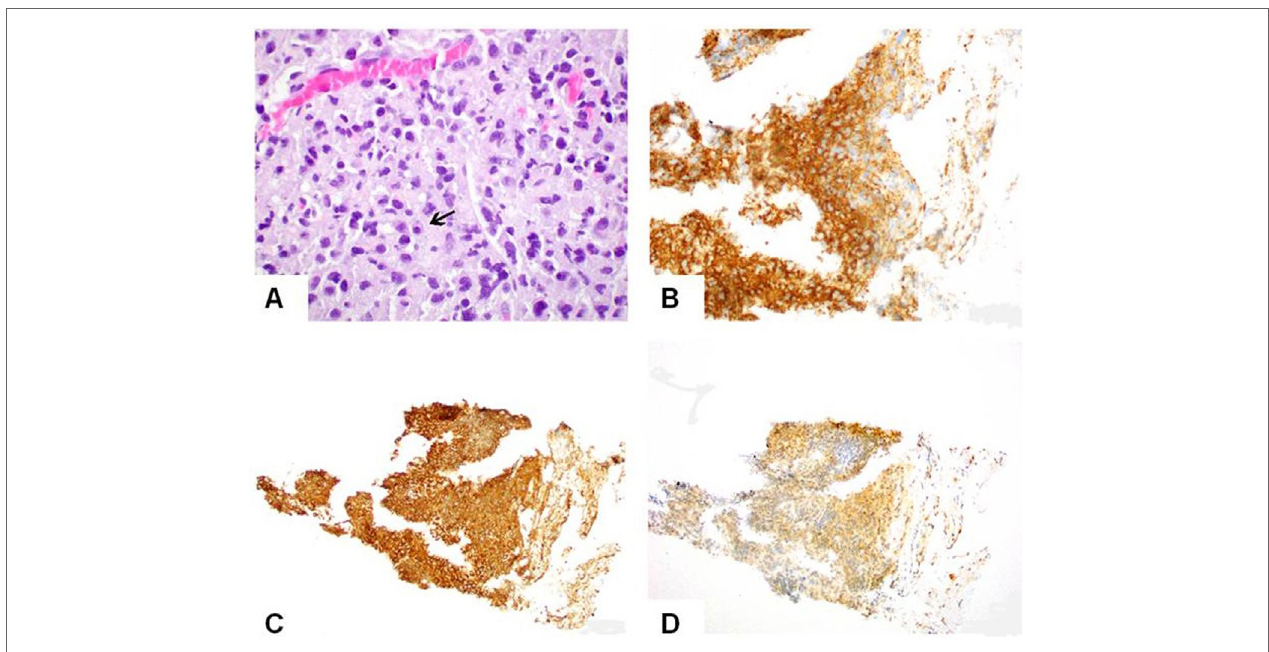
FIGURe 4 | Microscopic pictures of the plasmacytoma. (a) The tumor is entirely composed of plasma cells, some showing the typical perinuclear clearing associated with Golgi apparatus (arrow), H&E, 600 × . (B) Immunostain for CD138 shows positive (golden brown) staining in the tumor (200 × ). (C) Immunostains for lambda and (D) kappa light chains show a significant difference in staining intensity between kappa and lambda chains in favor of lambda chains (200 × ) demonstrating that the tumor is